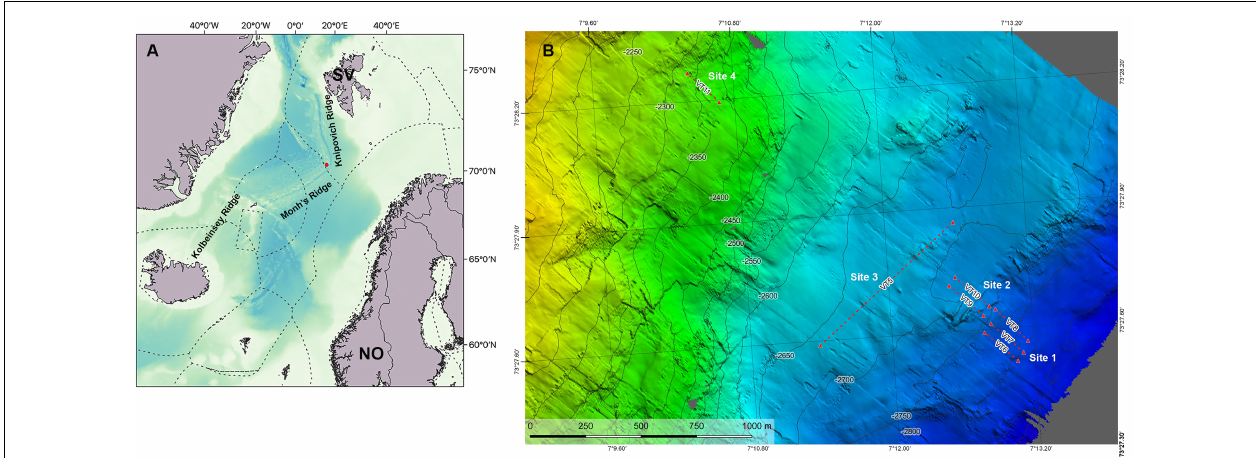
FIGURE 1 | Map of the study area. (A) Regional map showing the Arctic Mid-Ocean Ridge with the location of Mohn’s Treasure (red dot) and the three main ridges: KOR, Kolbeinsey Ridge; MR, Mohn’s Ridge; KR, Knipovich Ridge on the Mohn’s Treasure. (B) Bathymetry of the study area showing the video transects (VT). Mohn’s Treasure map made by Christian Malmquist, NTNU AUR